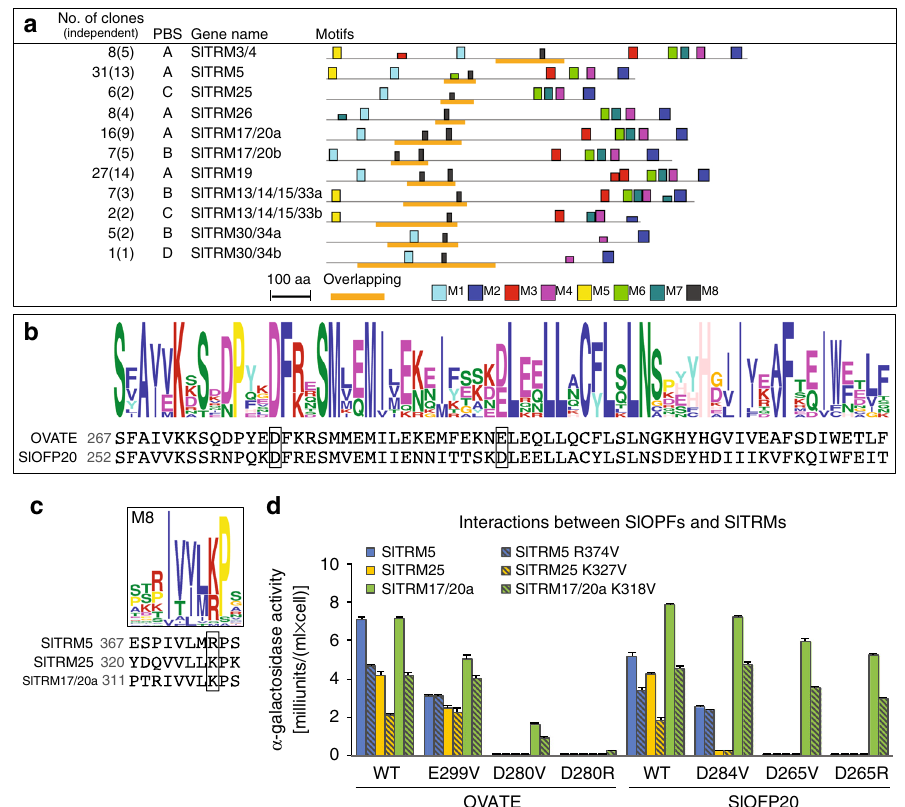
Fig. 2 Interactions of SlOFPs and SlTRMs in yeast. a The 11 SlTRMs identi fi ed in the Y2H screen to interact with OVATE. The Predicted Biological Score (PBS) A-D represents the highest to lowest interaction con fi dence scores, respectively. The eight motifs are indicated by the colored boxes. The orange bar highlights the overlapping region of independent SlTRM clones that were identi fi ed in the screen. b Conserved amino acids in the OFP domain. The boxed regions indicate the in vitro mutagenized amino acids. c The consensus TRM M8 motif. d Interactions between wild-type and mutant SlOFPs and SlTRMs in yeast. The error bars indicate the standard errors among three